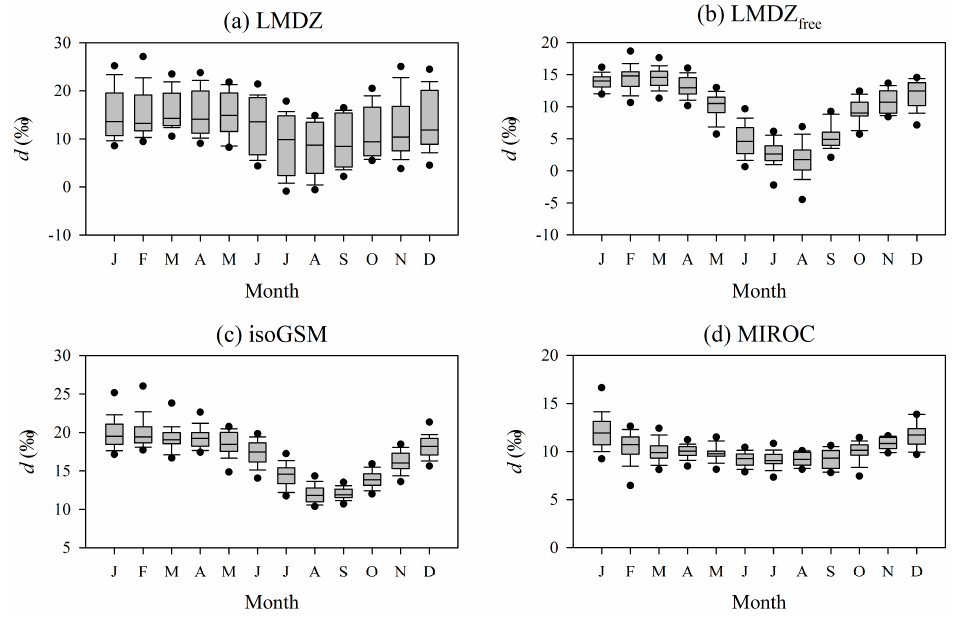
Figure 3. Monthly variations of d value for the nearest grid boxes to the Lanzhou city simulated using four isotope-enabled models (LMDZ, LMDZ free , isoGSM and MIROC). Table 3. Comparisons of mean d value, δ 2 H, correlation coe ffi cients ( r ) between d value and air temperature ( T ) or water vapor pressure ( e ), and the local meteoric water lines (LMWLs) during the wet (May to September) and dry (October to April) seasons at the four sites in the Lanzhou